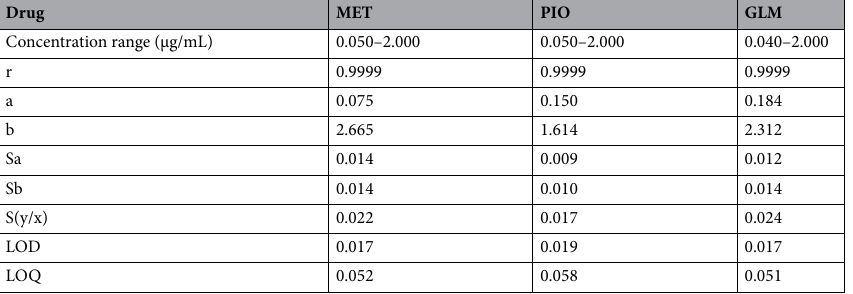
Table 5. Regression parameters for estimation of MET, PIO and GLM in spiked human plasma using the developed method. r: correlation coefficient; b: slope; a: intercept; S b : standard deviation of slope; S a : standard deviation of intercept; S y/x : residual standard deviation; LOQ: limit of quantitation; LOD: limit of detection.